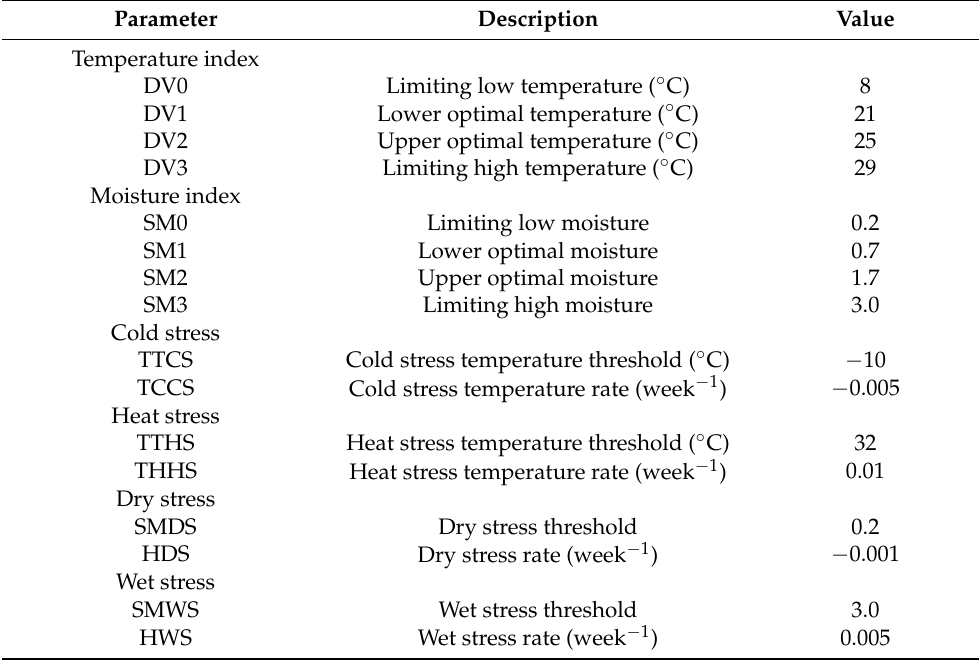
Table 1. CLIMEX parameter values for Calonectria pseudonaviculata